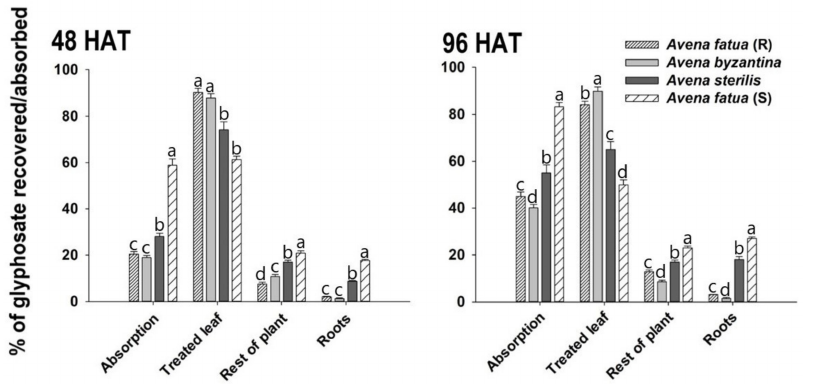
Figure 5. Percentage of glyphosate absorption (%recovered) and movement of glyphosate in plant (% of absorbed) of Avena species. Different letters correspond to different groupings according to Tukey ´ s test (0.05).